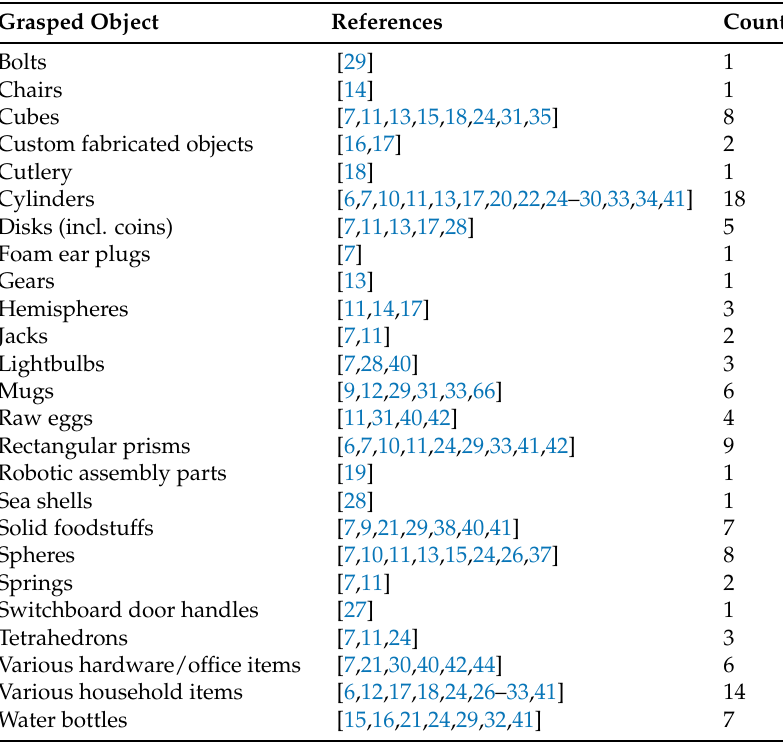
Table 13. Frequency of grasped objects.